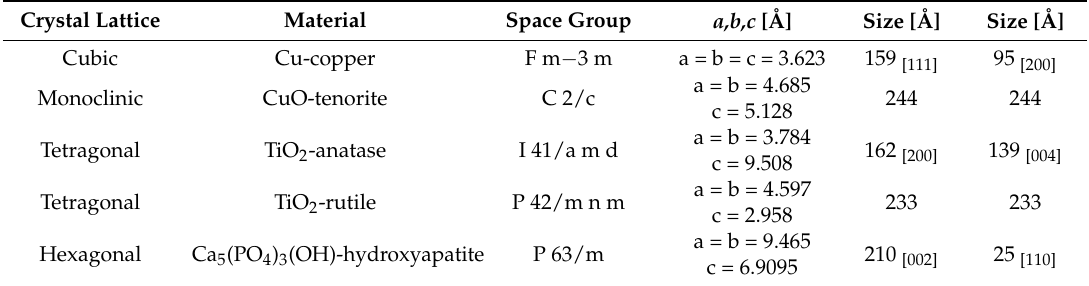
Table 1. Data derived from the analysis of the profiles in Figure 6a–d and in Figure 7a: a , b , c cell edges, domain size along two orthogonal directions. When a size anisotropy is present the nanocrystal has a non-isotropic habit, such as for elongated rod-like or flat disk